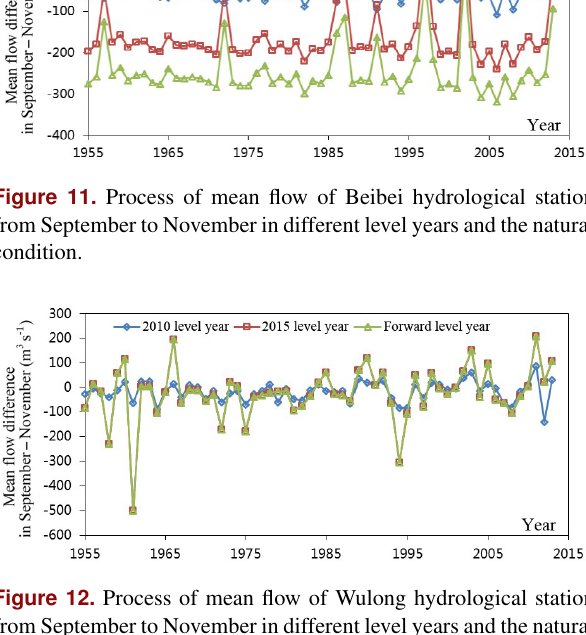
Figure 10. Process of mean flow of Gaochang hydrological station from September to November in different level years and the natural condition.